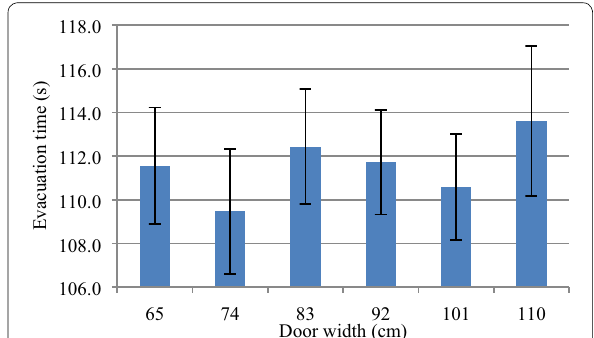
Figure 10 Histogram of evacuation time at different door width levels with confidence interval